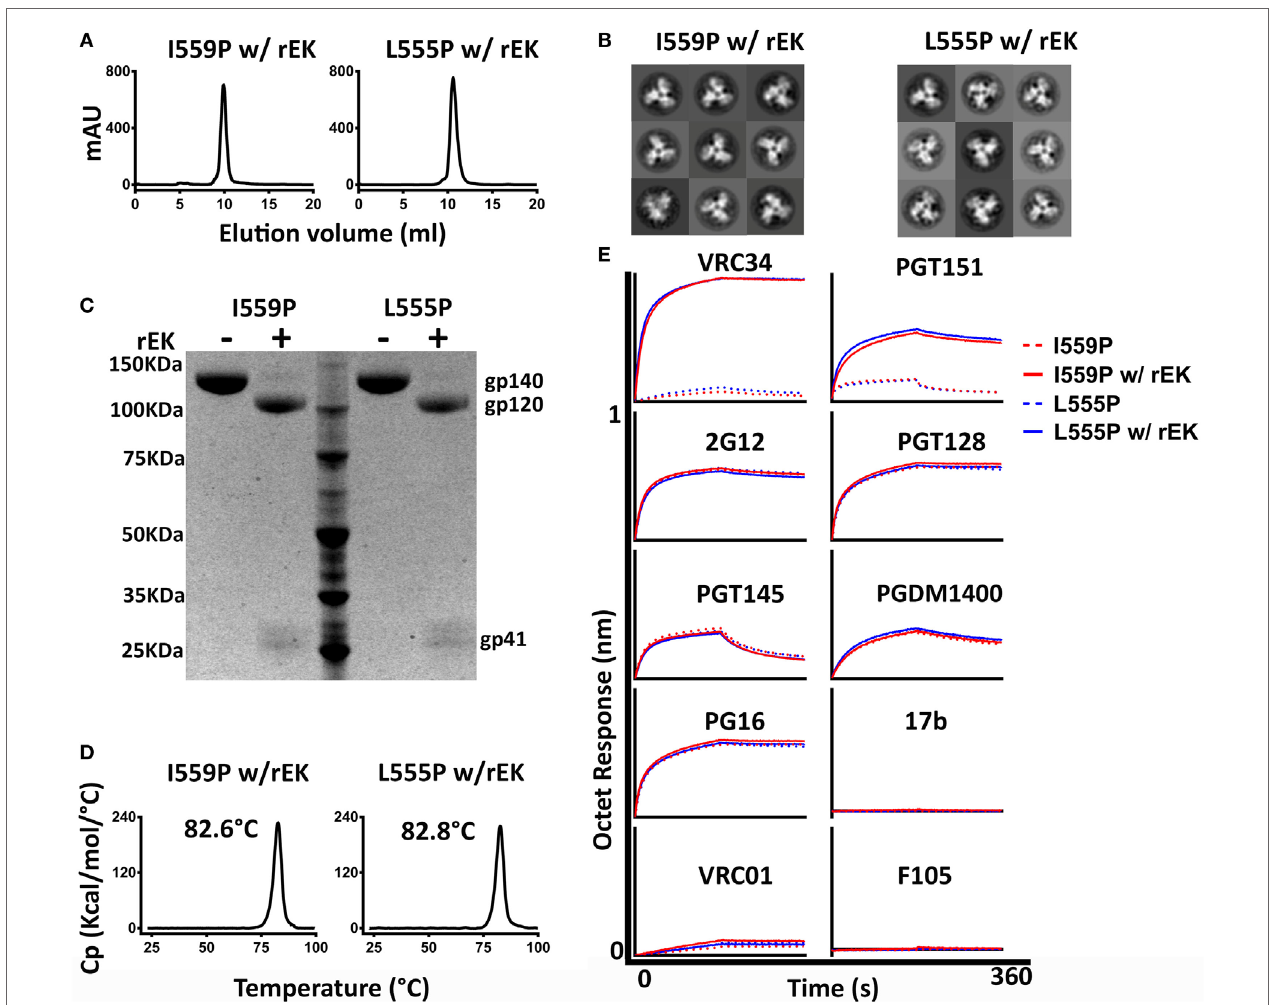
FigUre 5 | Biochemical, biophysical, and antigenic characterization of 16055 NFL TD 2CC + D 4 K I559P and L555P trimers after recombinant enterokinase (rEK) cleavage. (a) Size exclusion chromatography profiles of 16055 NFL TD 2CC + D 4 K I559P and L555P trimers after rEK cleavage (w/ rEK). (B) Comparison of 2D class averages from negative stain electron microscopy of cleaved 16055 NFL TD 2CC + D 4 K I559P and L555P trimers (w/ rEK). (c) Cleavage efficiency was determined by SDS-PAGE under reducing conditions. (D) Differential scanning calorimetry measurements of cleaved 16055 NFL TD 2CC + D 4 K I559P and